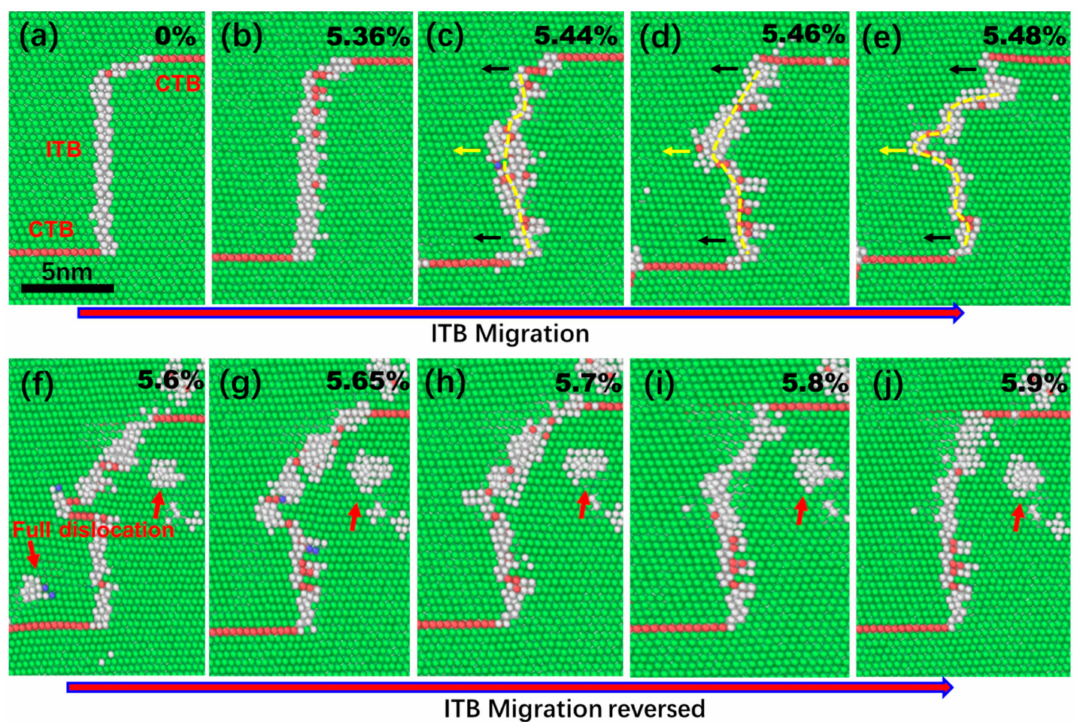
Figure 4. The atomic image of a twin-structured Al nanocrystal with tensile strains of 0, 5.36, 5.44, 5.46, 5.48, 5.60, 5.65, 5.70, 5.80, and 5.90%. ( a – e ) The ITB moves toward the left side and the originally straight ITB becomes irregular; ( f – j ) the irregular ITB moves back toward the right